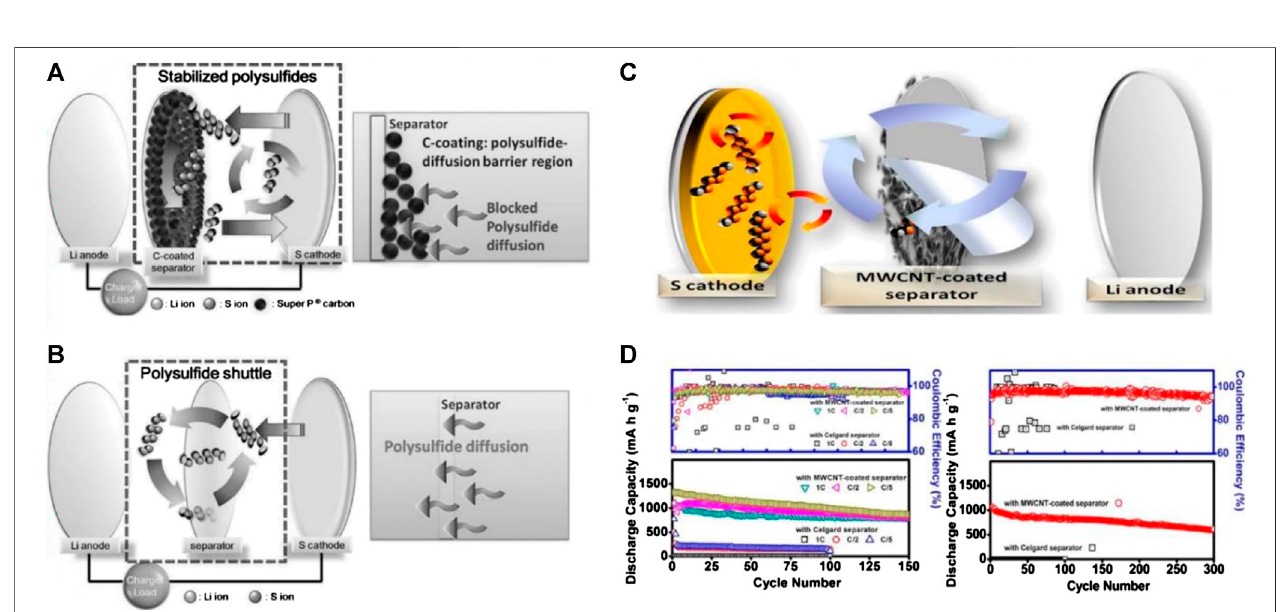
FIGURE 3 | Schematic cell con fi guration modi fi cation of LSBs (A) C-coated separator and the polysul fi de-diffusion barrier region (B) Celgard separator and the typical severe polysul fi de diffusion. Reproduced with permission from (Chung and Manthiram, 2014a) (C) The MWCNT-coated separator (D) Cell performance of the Li − S cells employing the MWCNT-coated separator. Reproduced with permission from (Chung and Manthiram, 2014c).